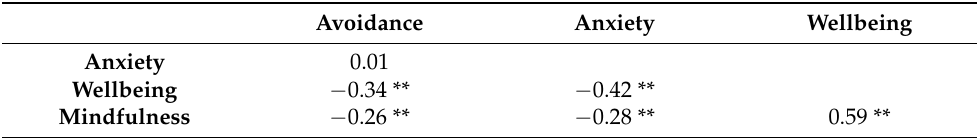
Table 2. Pearson correlations among avoidance, anxiety, wellbeing, and mindfulness (N = 391). Avoidance Anxiety Anxiety